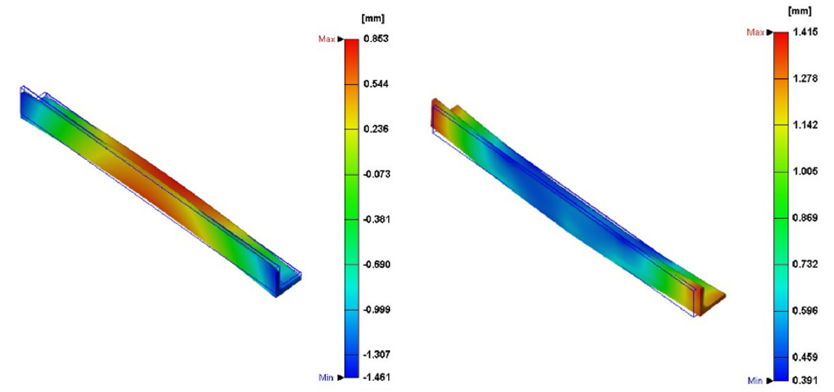
Figure 3. Warpage orientation simulation analysis results with different glass fiber [17].